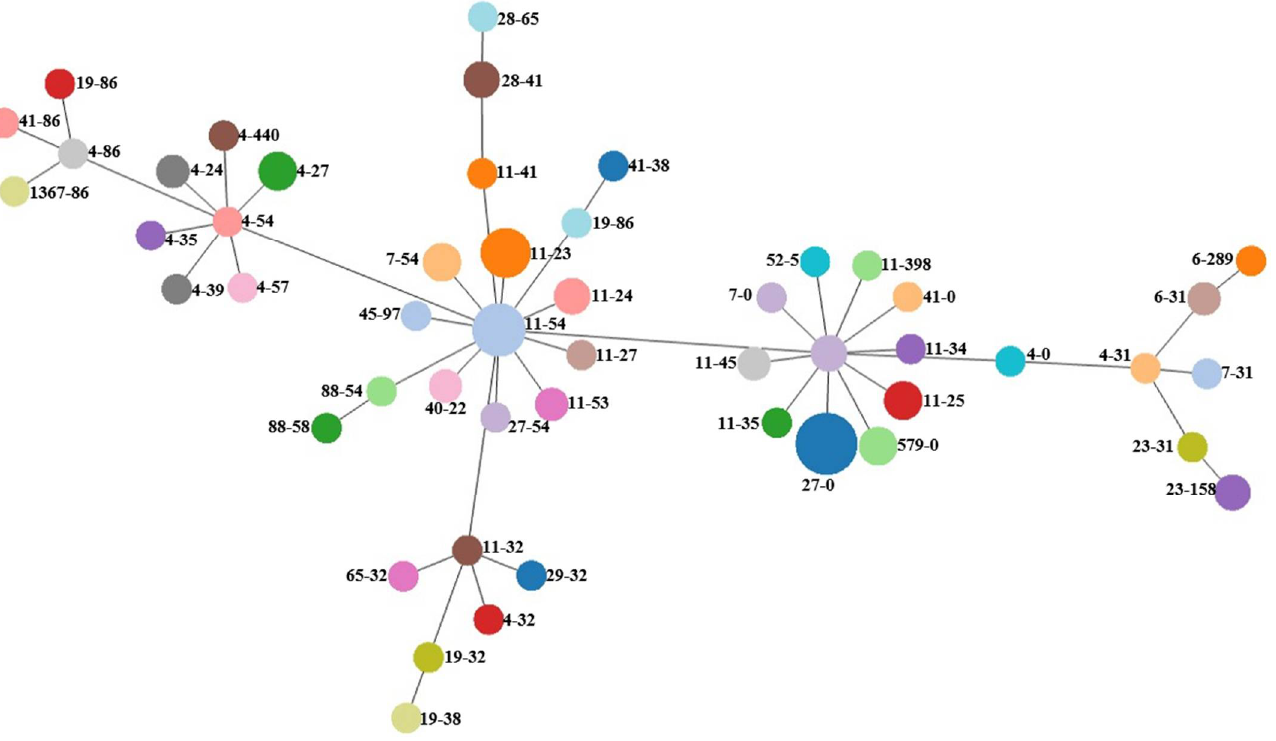
Figure 1. goeBURST diagram for the CH clonotyping dataset of E. coli isolates. An eBURST diagram was calculated using PHYLOViZ with the goeBURST algorithm. E. coli isolates were grouped according to their CH profiles.